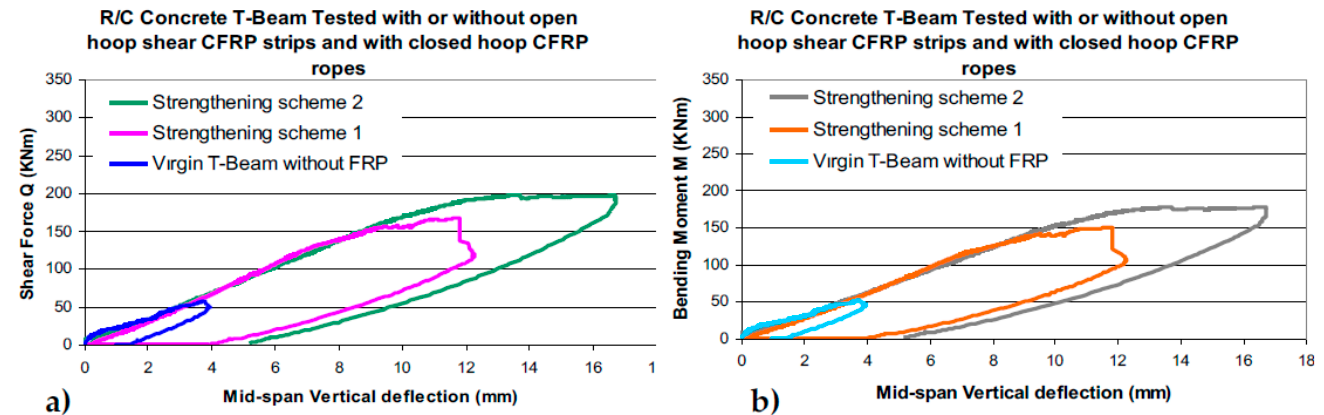
Figure 20. Comparison of the measured response between the prototype RC Virgin T-beam and this T-beam having been retrofitted with the 1st and 2nd st rengthening schemes . ( a ) Shear force versus the deflection at mid-span. ( b ) Bending moment versus the deflection at mid-span.